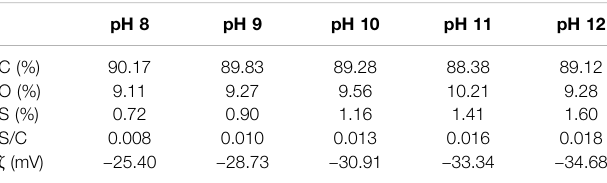
TABLE 1 | Elemental percentage, atomic ratio, and surface zeta potential of graphene sheets with different initial pH values during electrochemical